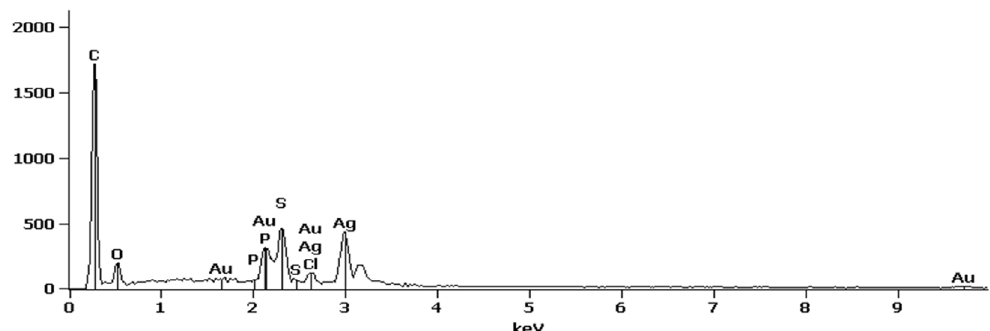
Figure 5. EDS spectra of 5 AgPNP-BL UF membrane surface.